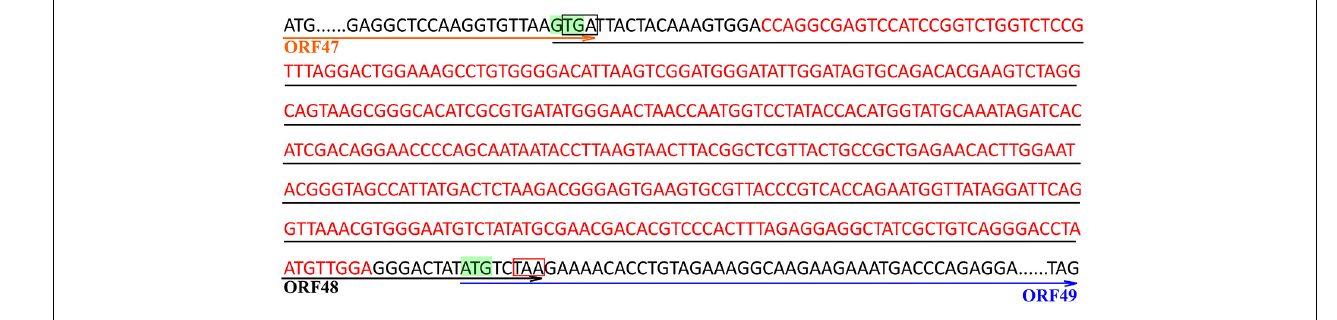
5.8, 94.4, and 64.2%, respectively. The protection rate was